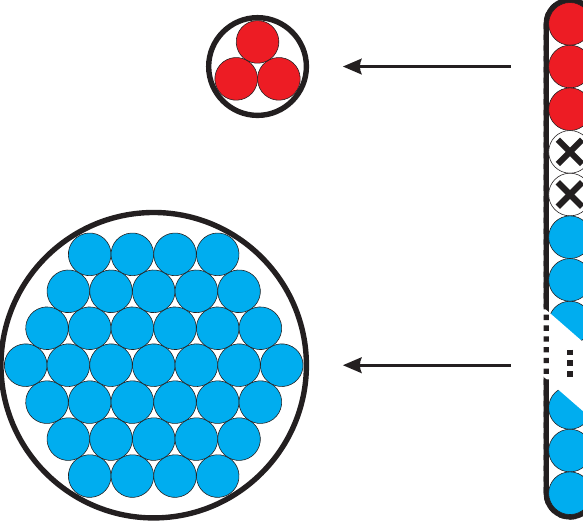
filter. The zinc lamp with its distinctive emission peak around 213.9 nm is used for calibrating the wavelength mapping onto the CCD. The optional flow cell is used to supply known amounts of traces gases for calibration